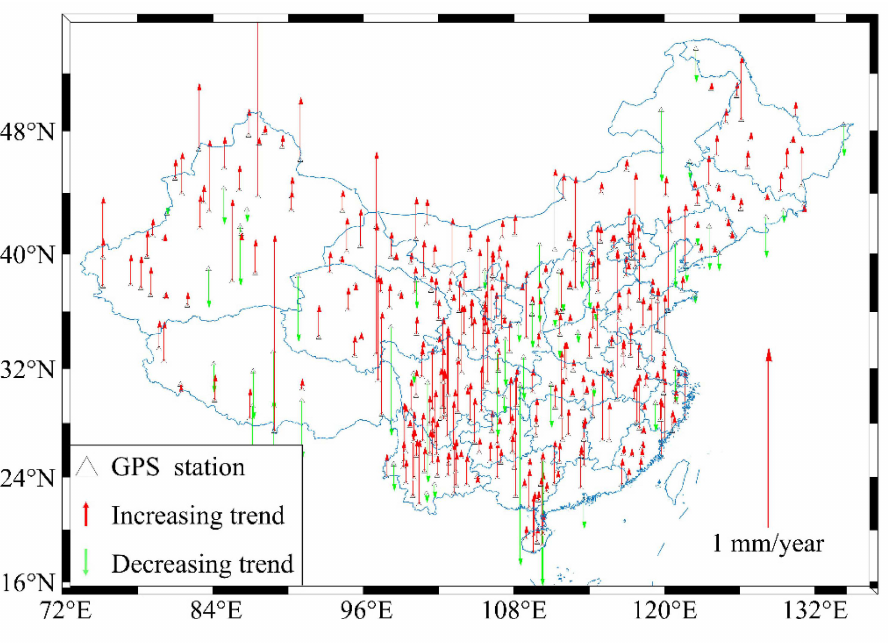
Figure 4. Long-term variation trend of the GNSS PWV from 2011 to 2018